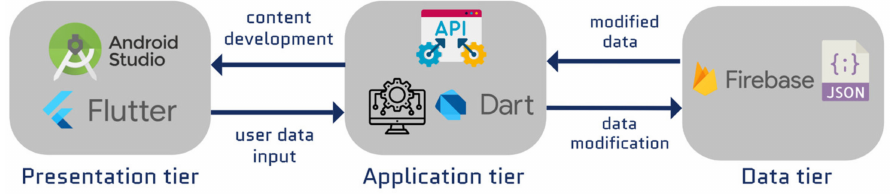
Figure 1. The ACUX-R 3-tier